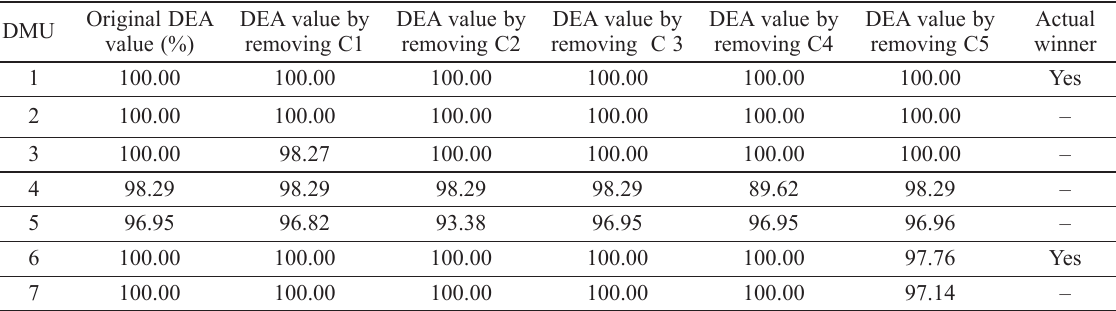
Table 8. Results of sensitivity analysis of criteria for case project 2 Original DEA DEA value by DMU value (%) removing